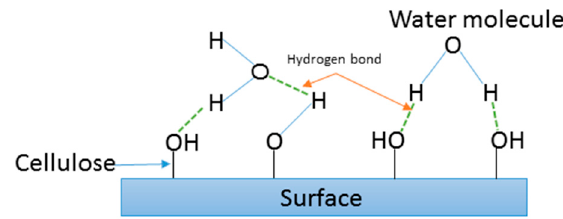
Figure 7. Schematic diagram for the hydrogen bond between water molecules and cellulose [24].